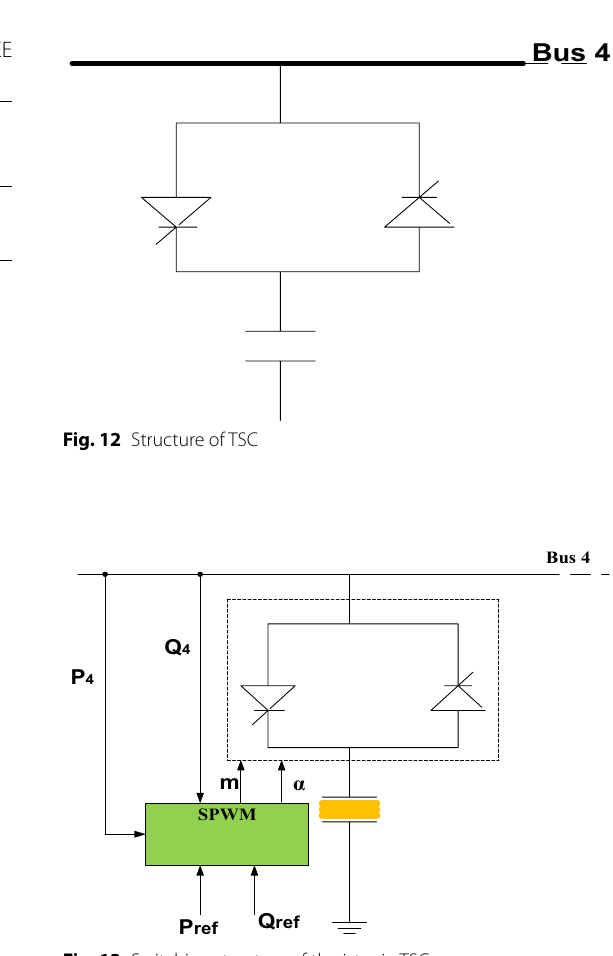
Fig. 13 Switching structure of thyristor in